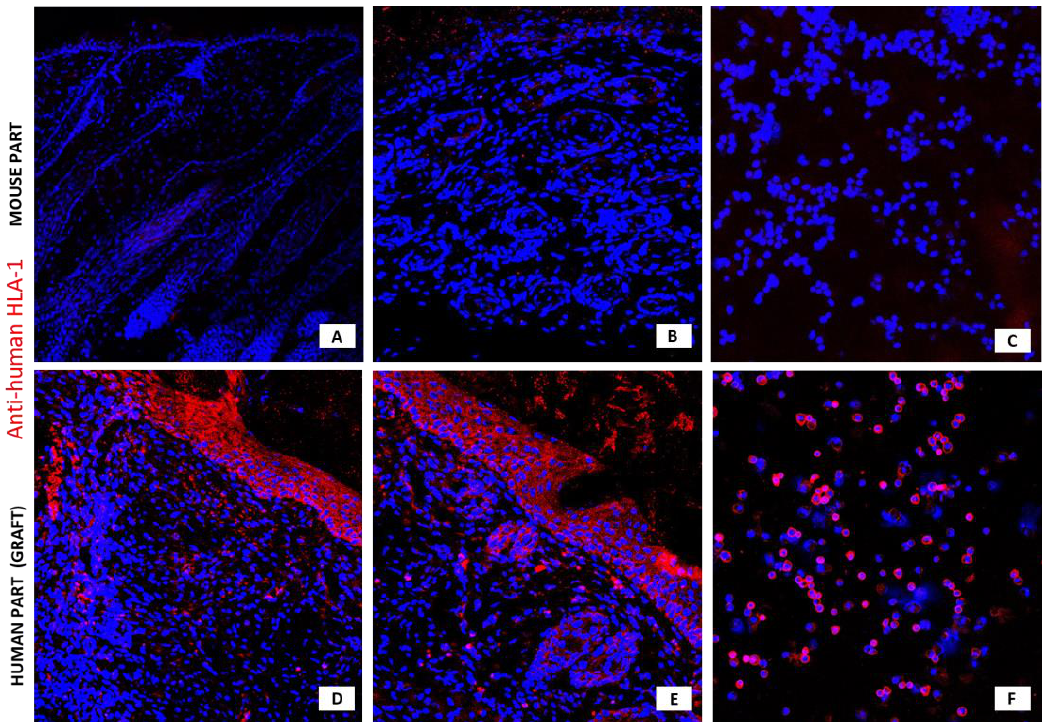
Figure 7. Confocal microscopy images of specimens stained with anti-human HLA-1 Ab. Mouse part of the specimen ( A , B ) and the newly formed epidermis after transplantation of human KCs into the wound ( D , E ). Cells isolated from the mouse skin ( C ) and from the newly formed epidermis in the graft area ( F ). Grafted keratinocytes were isolated from skin preserved in anhydrous NaCl for 1 month. Red-stained cells expressing HLA-1 (Alexa Fluor 633). Nuclei stained blue (Hoechst), magnification 5× ( A ) and 10× ( B – F ).